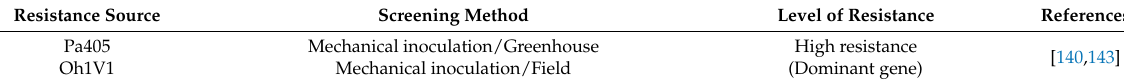
Table 3. Summary on genes conferring resistance against maize dwarf mosaic virus